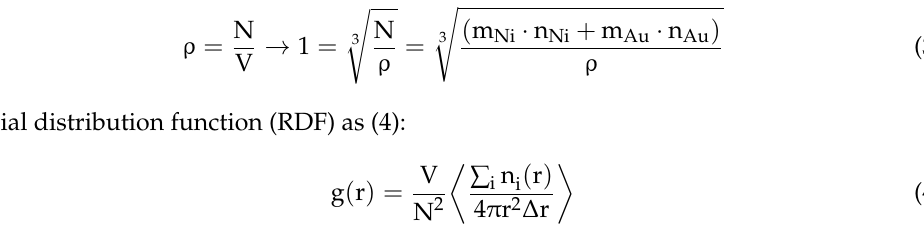
Figure 1. The shape ( a ), g(r) of NiAu 5324 alloy ( b ) at T = 300 K, and heating rate 4 × 10 12 K/s.